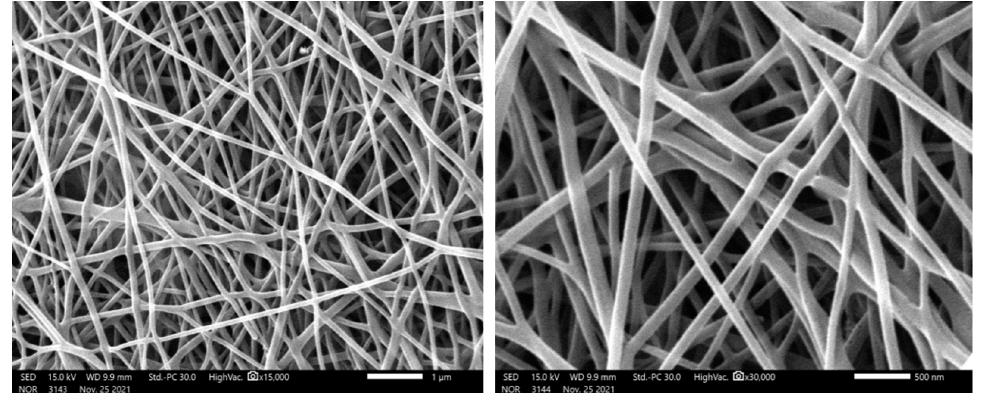
Figure 3. Two SEM image magnifications of the prepared carbon nanofibers.